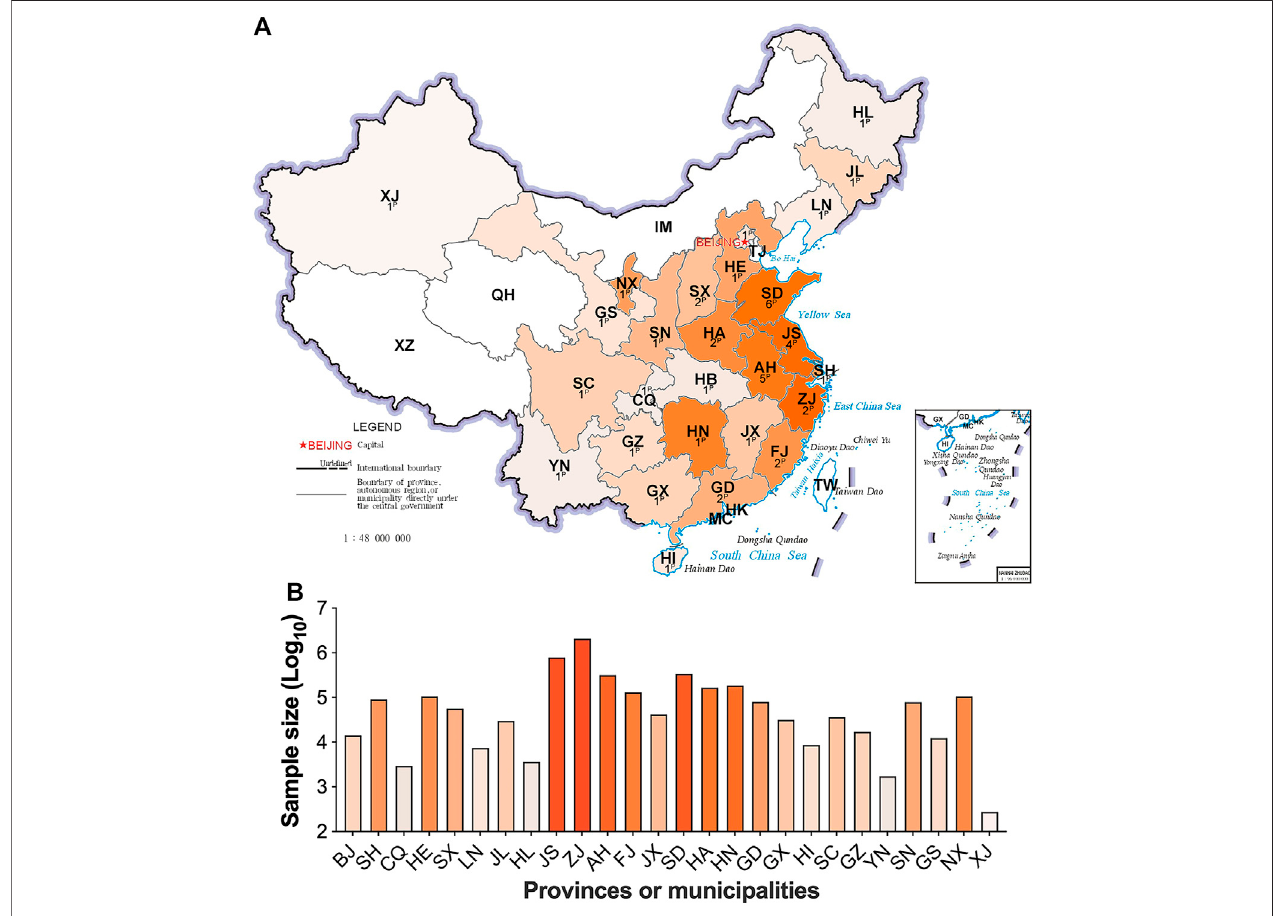
FIGURE 1 | The contribution and distribution of study centers/laboratories at each province/municipality. Figure 1A , the number and location of participating centers/laboratories; Figure 1B , the sample size at each province/municipality. The superscript capital P means the number of participating centers/laboratories. HL, Heilongjiang; JL, Jilin; LN, Liaoning; XJ, Xinjiang; IM, Inner Mongolia; TJ, Tianjin, HE, Hebei; SX, Shanxi; SN, Shaanxi; NX, Ningxia; GS, Gansu; QH, Qinghai; SD, Shandong; JS, Jiangsu; AH, Anhui; HA, Henan; SH, Shanghai; HB, Hubei; CQ, Chongqing; SC, Sichuan; XZ, Tibet; ZJ, Zhejiang; JX, Jiangxi; HN, Hunan; GZ, Guizhou; YN, Yunnan; FJ, Fujian; TW, Taiwan; GD, Guangdong; GX, Guangxi; HK, Hongkong; MC, Macau. Areas with no data submitted show no color. The darker in orange, the larger in sample